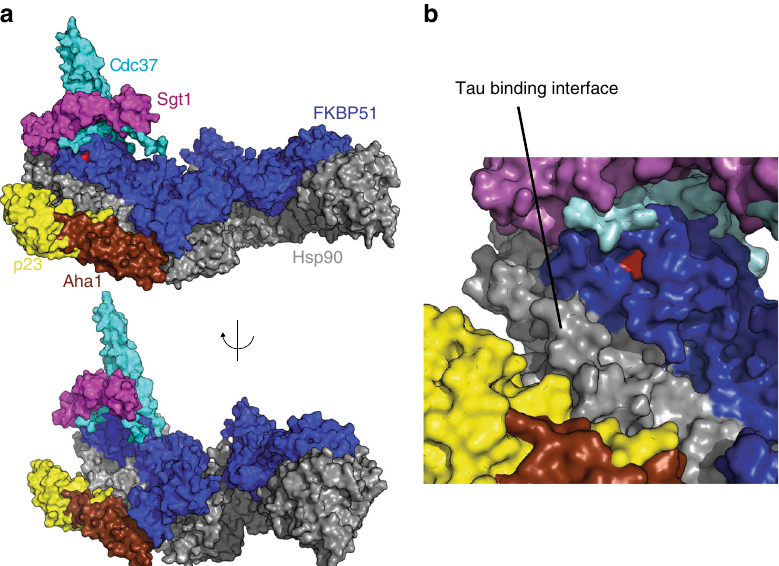
Fig. 6 The ternary complex allows asymmetric Hsp90/co-chaperone interactions. a , b The Tau-binding interface on the Hsp90 surface is largely distinct from the binding sites of FKBP51 and other co-chaperones, which in turn do not overlap. PDB codes are: human Cdc37 (PDB id: 5fwk), Arabidopsis thaliana Sgt1 (PDB id: 2xcm), yeast p23 (PDB id: 2cg9), and yeast Aha1 (PDB id: 1usv). FKBP51's catalytic PPIase pocket, which is located in the FK1 domain, is highlighted in